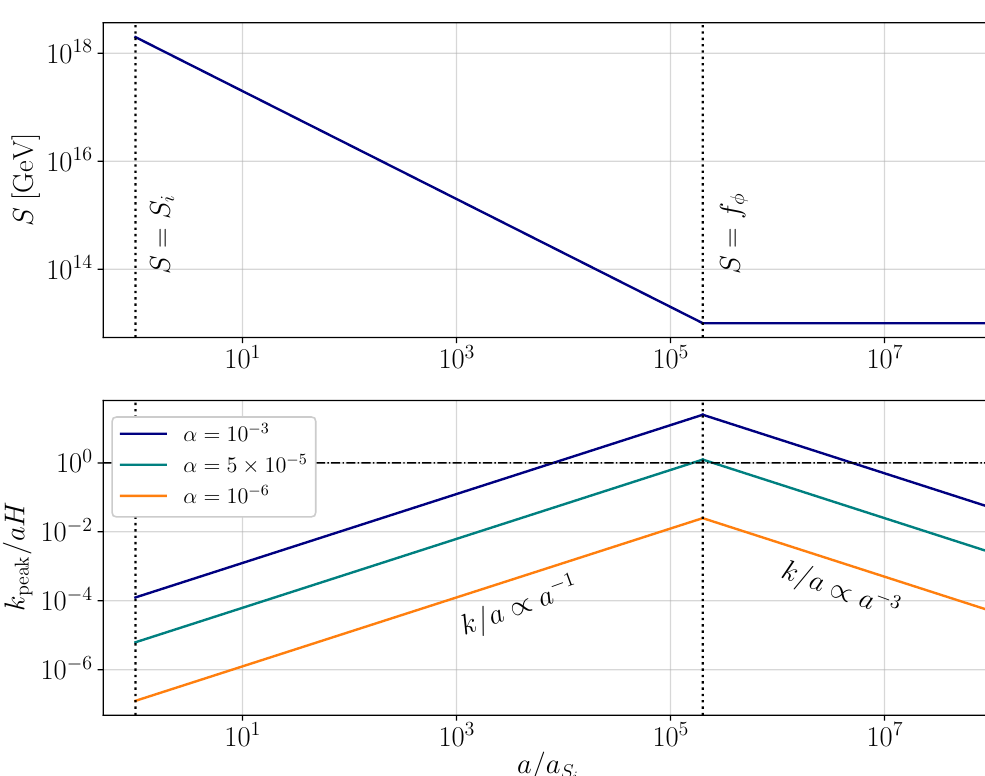
Figure 1: In the upper panel the evolution of the radial component is shown, = 2 × 10 18 GeV (left black dotted line) and finally settling at starting out at S i S = f φ = 10 13 GeV once the scale factor has grown to a line). The lower plot shows the ratio of the dark photon growth rate k the Hubble rate during radiation domination. Once this ratio surpasses unity (black dash-dotted line), tachyonic production of photons becomes efficient. This is only the case for large enough α , with the green line being close to the limiting case, where α ≈ α min